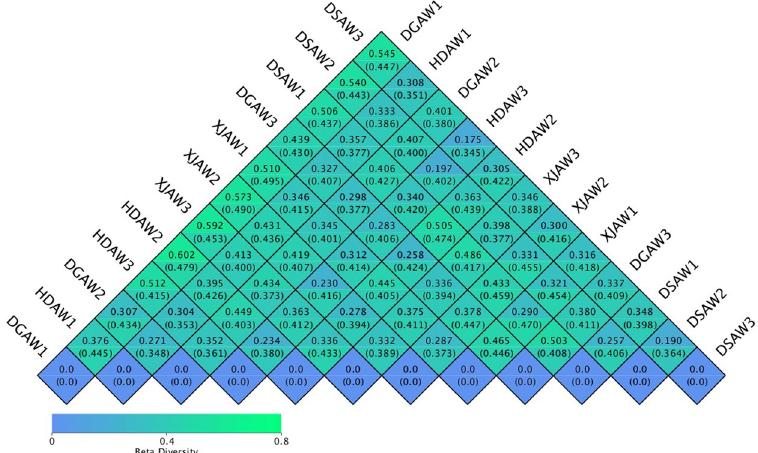
Figure 4. Beta diversity heat map based on the UniFrac distance. The upper triangle is the weighted distance. The distance from the lower triangles is the unweighted distance. Abbreviations: HDAW, F. syreitschikowii ; XJAW, F. gracilis ; DSAW, F. ferulaeoides; and DGAW, F. lehmannii . The numbers indicate the root depth (1, 2, and 3 represent the 3, 20, and 40 cm depths, respectively).